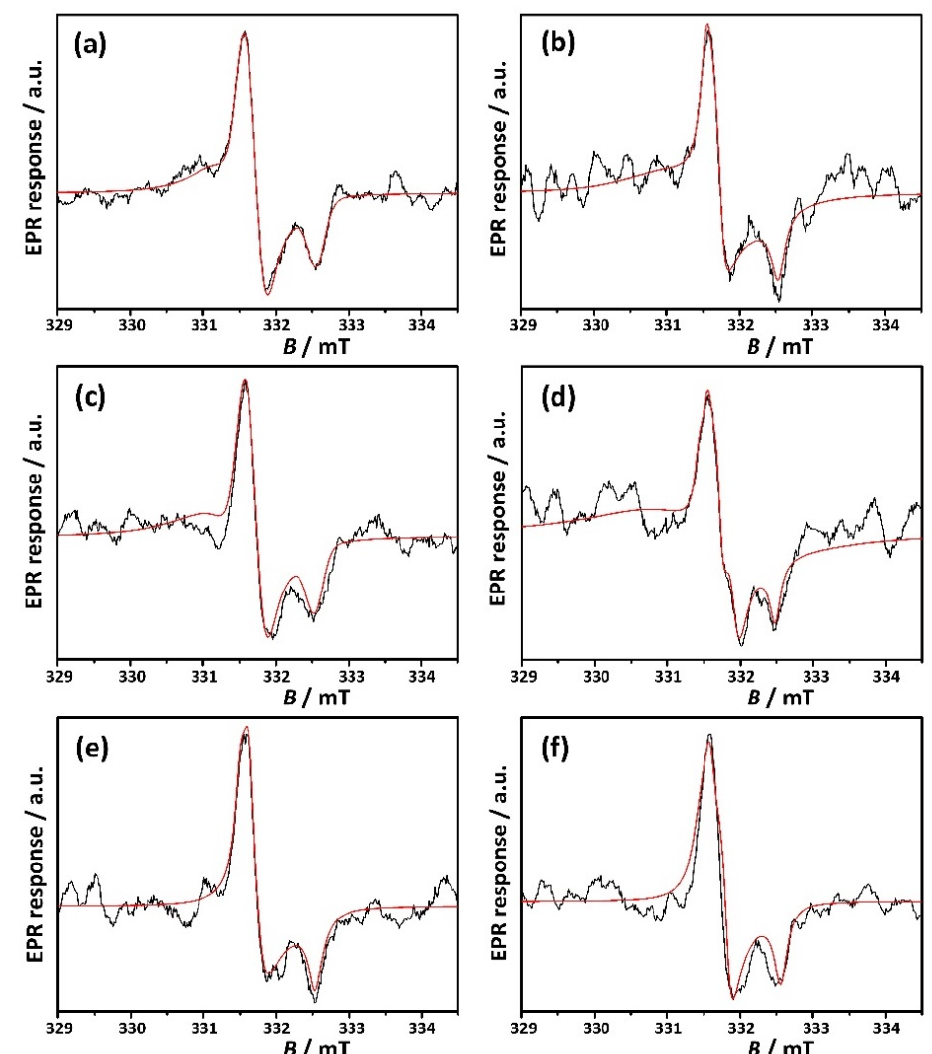
Figure 4. Experimental and simulated EPR spectra of the precipitates formed after 60 min reaction time (150 min in the case of Ser) in ( a ) control system and in the presence of 5 mmol dm − 3 ( b ) aspartic acid (Asp), ( c ) lysine (Lys), ( d ) asparagine (Asn), ( e ) serine (Ser) and ( f ) phenylalanine (Phe). c (CaCl 2 · 2H 2 O) = c (Na 2 HPO 4 ) = 5 mmol dm − 3 , c (NaCl) = 0.15 mol dm − 3 , c (AAs) 5 mmol dm − 3 , pH initial = 7.4, ϑ = (25.0 ± 0.1) ◦ C, magnetic stirring.